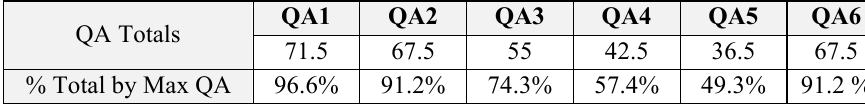
Table 3 : Quality of studies – Total